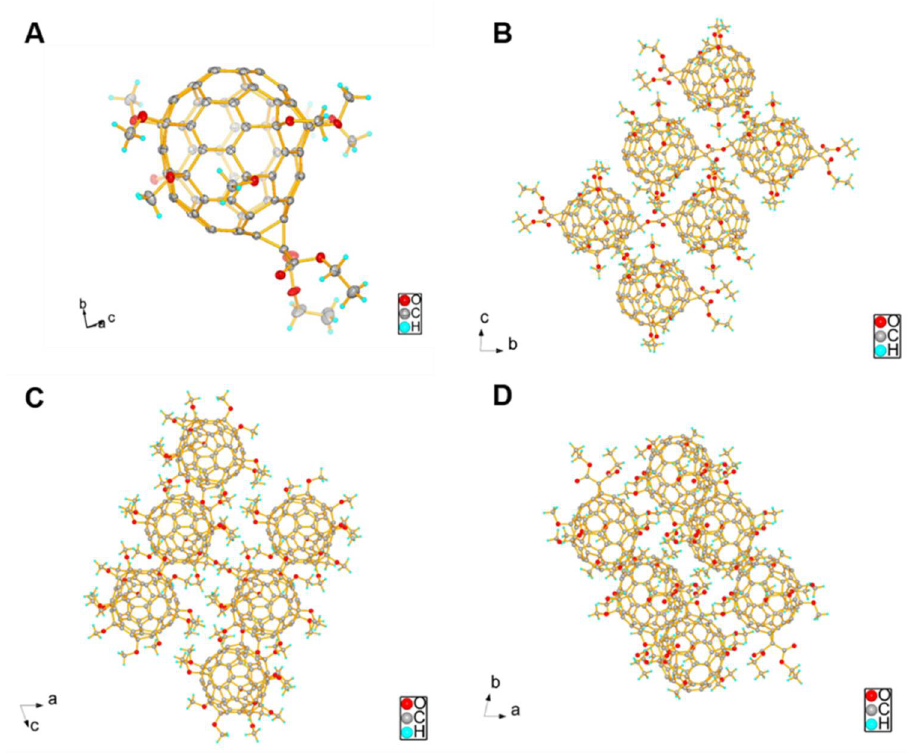
Figure 1. Crystal structure of C 70 (OCH 3 ) 10 [C(COOEt) 2 ]. ( A ) ORTEP drawing with 50% ellipsoid probability. The molecular packing along a-axis ( B ), b-axis ( C ), and c-axis ( D ). The UV-vis absorption spectra of the C 70 (OCH 3 ) 10 , C 70 (OCH 3 ) 10 [C(COOEt) 2 ], and C 70 (OCH 3 ) 10 [C(COOEt) 2 ] 2 were measured at room temperature. As shown in Figure 2, the C 70 (OCH 3 ) 10 exhibited two absorption peaks at 435 and 480 nm in the visible region, and one absorption peak at 315 nm in the ultraviolet region. By contrast, there was no absorption peak in the visible region, but there was one absorption peak in the ultraviolet region (313 nm) for C 70 (OCH 3 ) 10 [C(COOEt) 2 ], which was slightly blue-shifted with respect to the C 70 (OCH 3 ) 10 . Similarly, the C 70 (OCH 3 ) 10 [C(COOEt) 2 ] 2 showed an absorption peak at 305 nm, which was further blue-shifted compared with that of the C 70 (OCH 3 ) 10 [C(COOEt) 2 ]. Moreover, a broad shoulder peak around 370 nm was ob- served for the C 70 (OCH 3 ) 10 [C(COOEt) 2 ]. The blue-shifting of the absorption peaks of both C 70 (OCH 3 ) 10 [C(COOEt) 2 ] and C 70 (OCH 3 ) 10 [C(COOEt) 2 ] 2 was caused by the decrease in the π -conjugated system of the C 70 cage, indicating that the energy gap between the S 1 and S 0 became